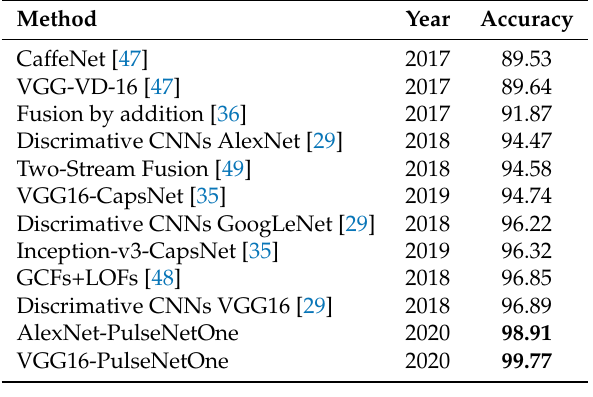
Table 3. A comparison between state-of-the-art and PulseNetOne results on the AID data set. The entries in bold show the method with the best classification for the network.